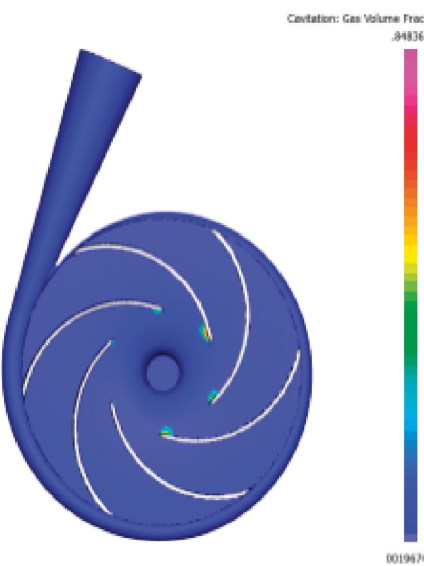
Figure 7: Gas volume fraction